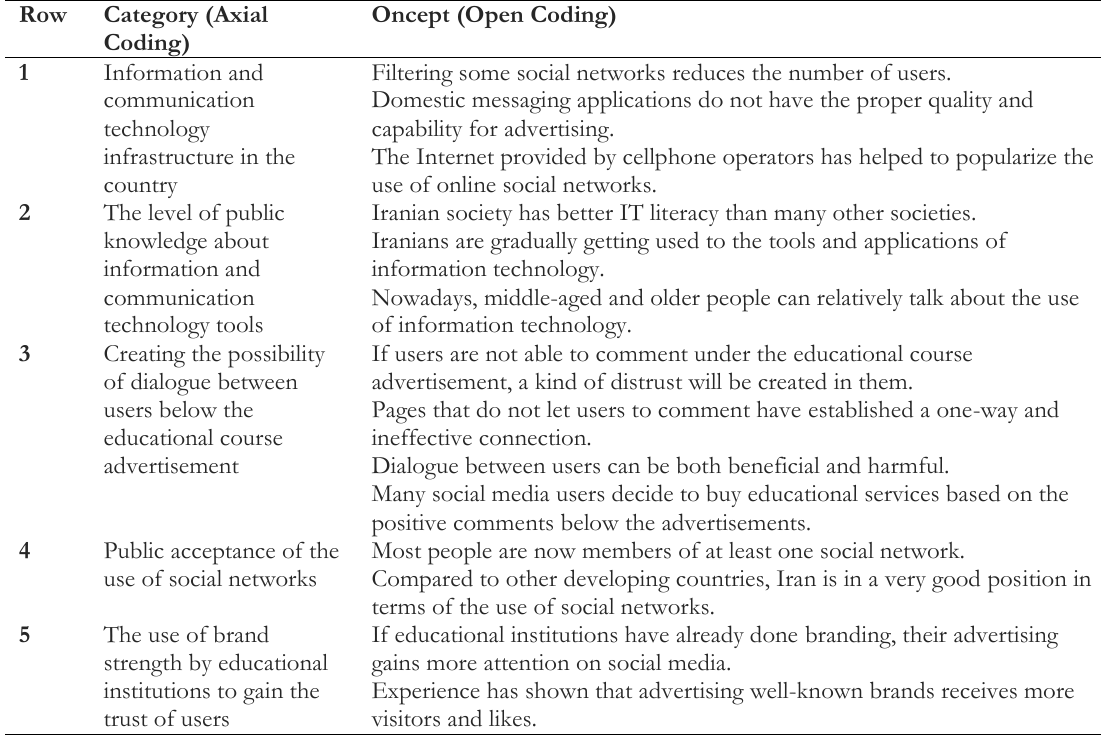
Table 2. The identified categories with relevant